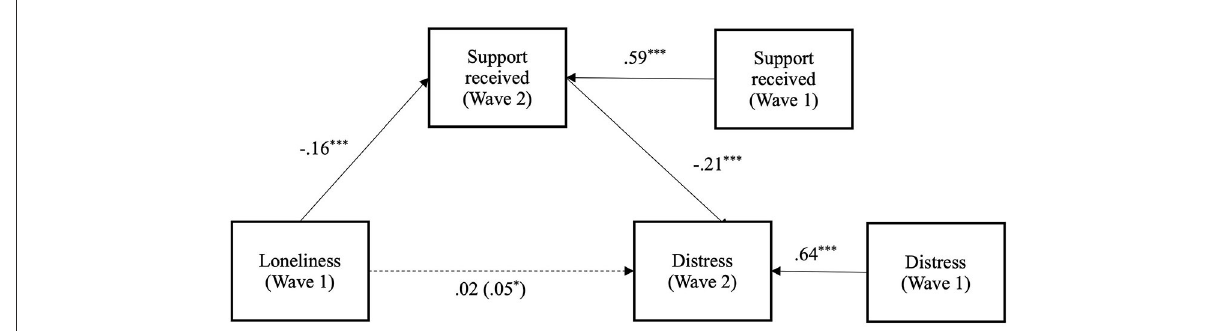
FIGURE6 Longitudinal mediation model of the effect of loneliness at wave 1 on psychological distress at wave 2, via social support received at wave 2 and provision of social support at wave 2, while controlling for wave 1 levels of distress, provision of social support, and social Support Received (* p < 0.05. ** p < 0.01. *** p <